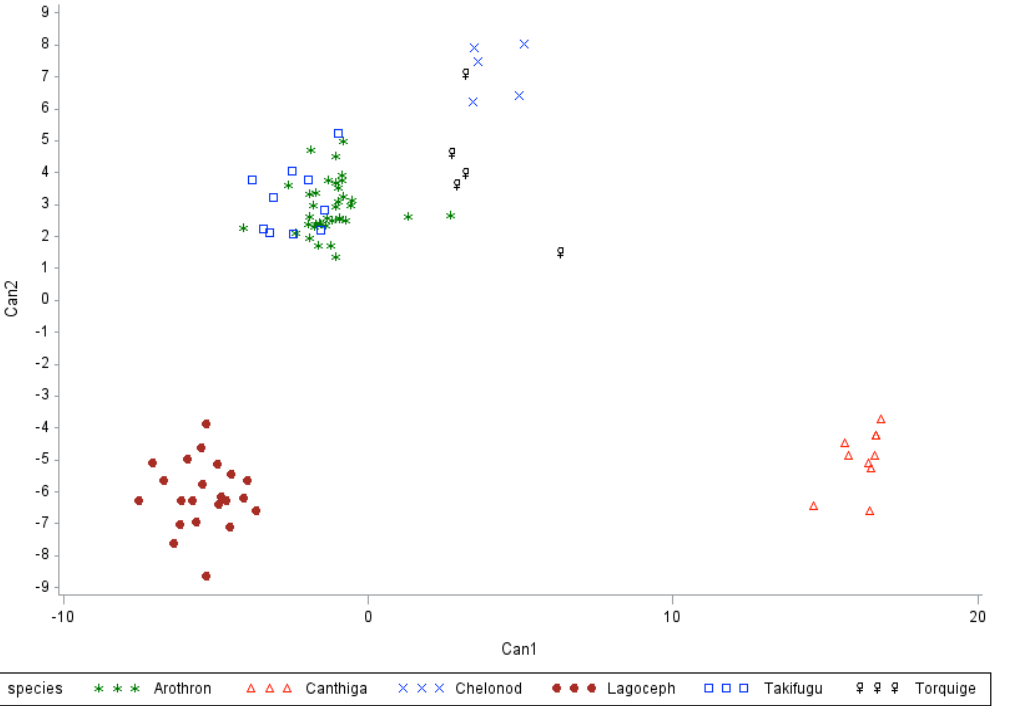
Figure 4. Scatter plot of first two factors from discriminant function analysis for Tetraodontidae from southeastern India (cumulative variations: